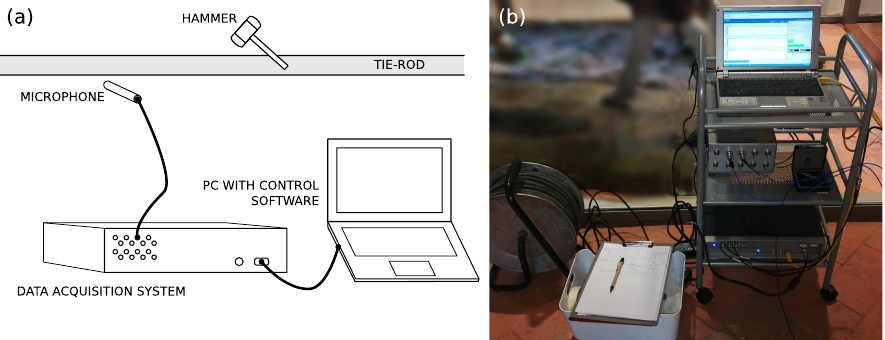
Figure 5. Professional microphone layout: ( a ) instrumentation for tie-rod frequency measurements with aprofessional microphone; ( b ) instrumentation used during the testing campaign in Certosa di Pisa detailed in Section